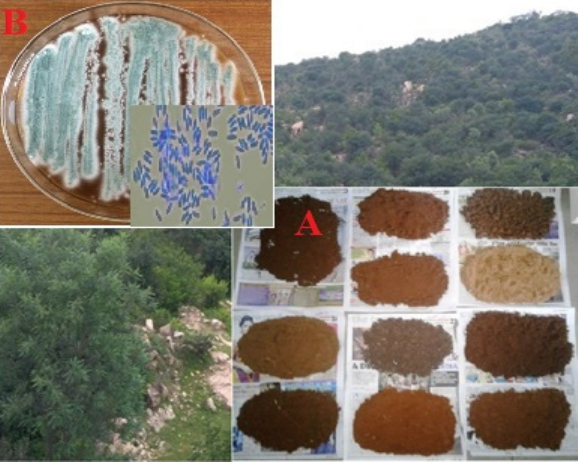
Figure 1. ( A ) Soil collection area and soil sample and ( B ) Metarhizium robertsii insect pathogenic fungi.